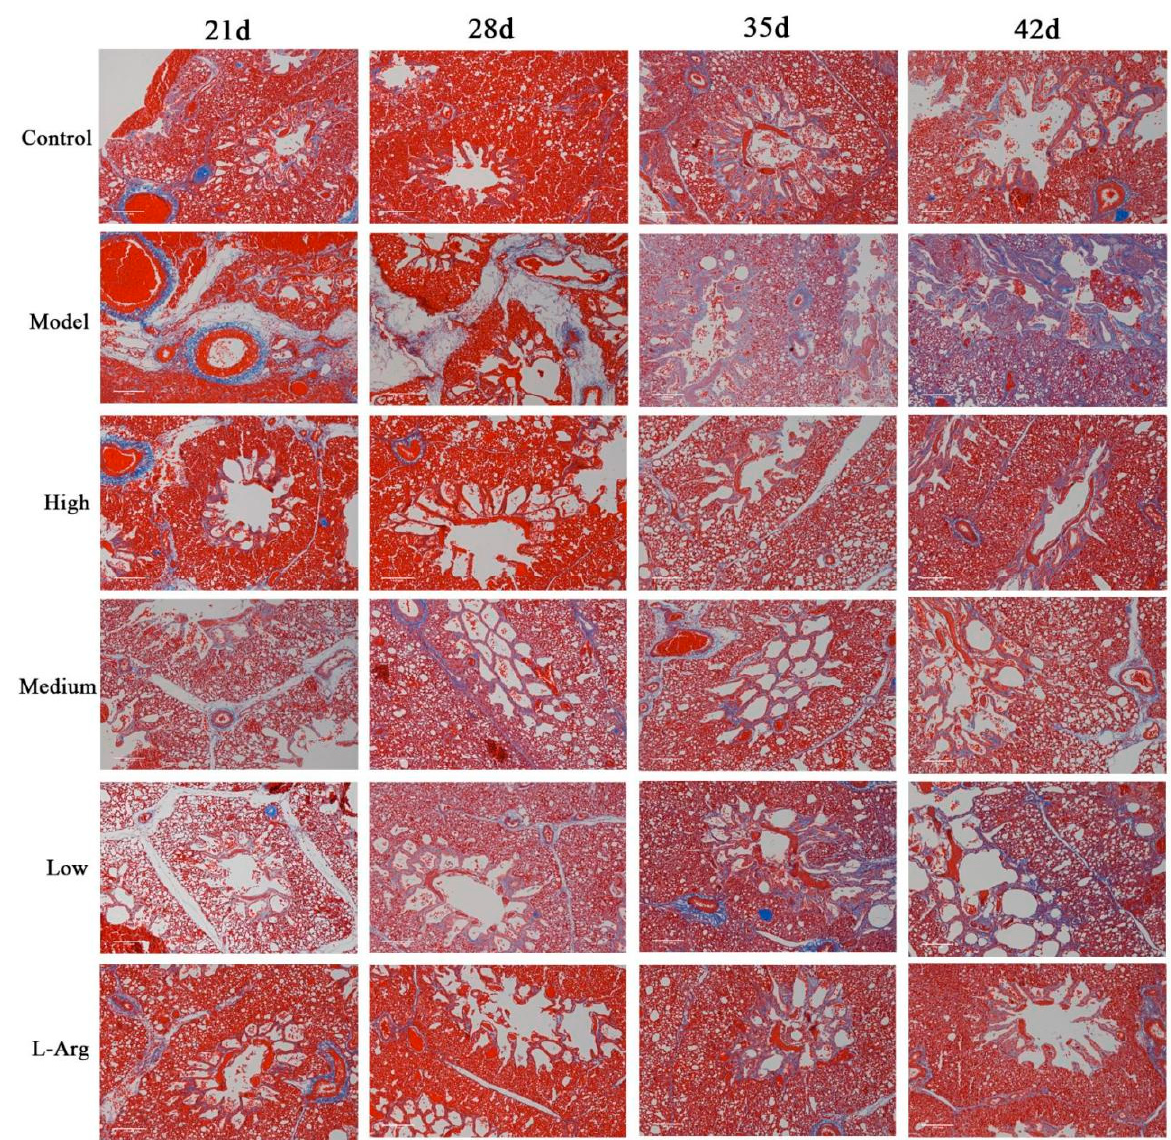
Figure 2. The effect of QLJP on broiler pulmonary fibrosis by Masson’s trichrome staining (100 × , scale bar = 100 μ m). Control is the control group, Model is the model group, High is the high dose group of QLJP, Medium is the medium dose group of QLJP, Low is the low dose group of QLJP, and L-Arg is the L-Arginine group.